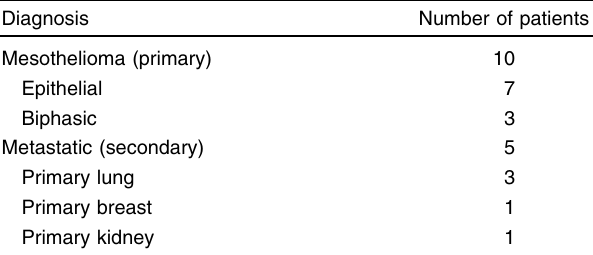
Table 2 Summary of the different etiologies of malignant pleural effusion in patients undergoing tetracycline poudrage pleurodesis